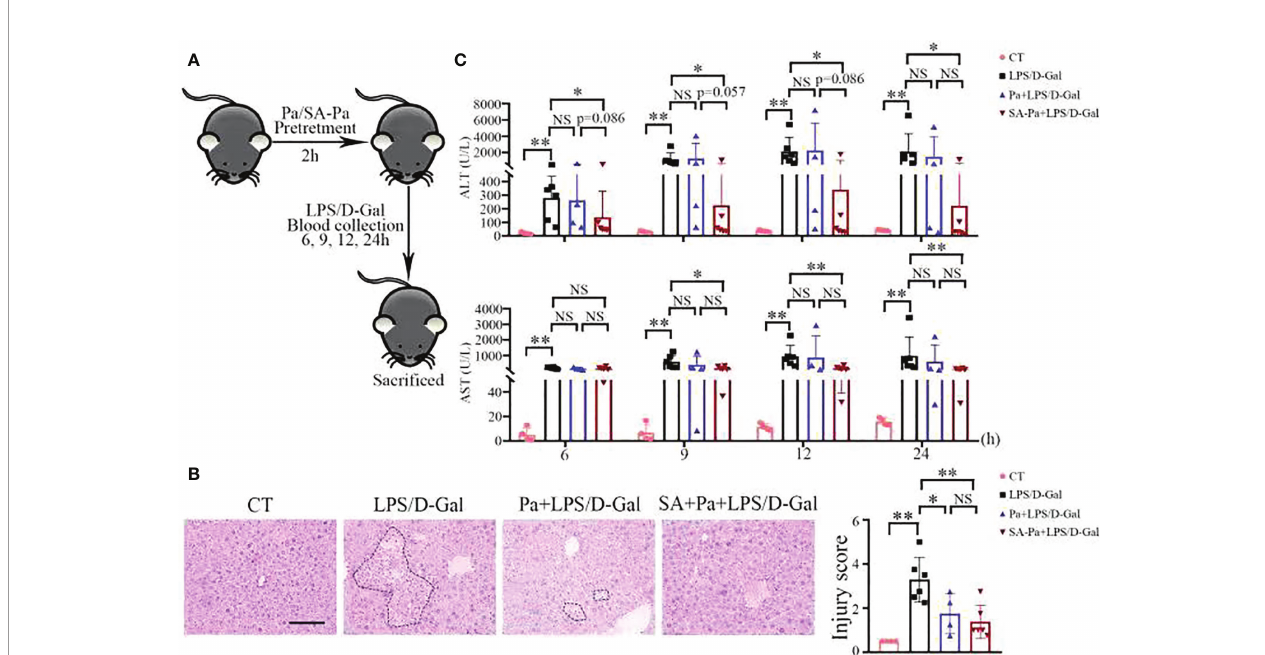
FIGURE 2 | SA-Pa or Pa protected the liver from the LPS/D-Gal induced injury. (A) Experimental design for LPS/D-Gal injury with or without Pa/SA-Pa pretreatment. (B) Respective H&E staining and quantitative results (scale bar = 100 m m). (C) Serum levels of ALT and AST. (CT group, n = 4; LPS/D-Gal group, n = 6; Pa group, n = 4; SA-Pa group, n = 6; NS p > 0.05; *p < 0.05; **p < 0.01)